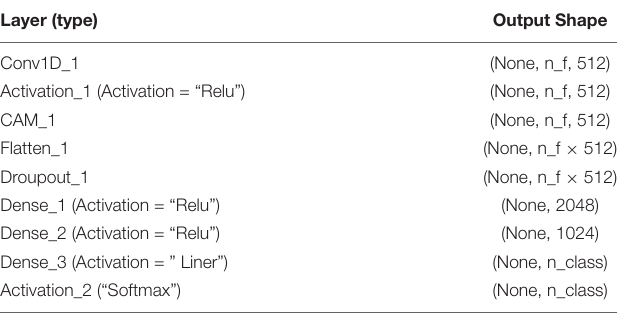
TABLE 1 | The network structure of